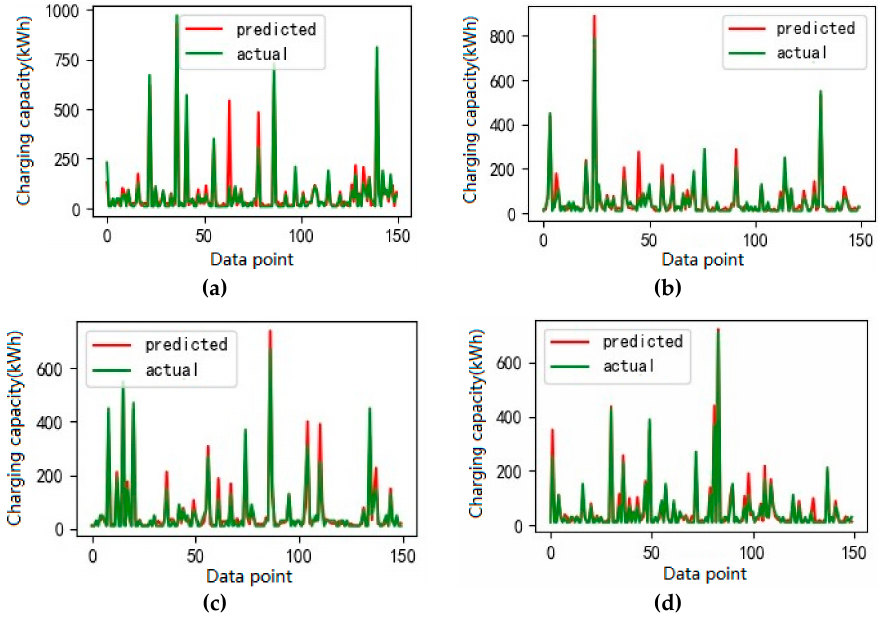
Figure 7. Performance of RF model on testing data set: ( a ) n = 40, m = 40; ( b ) n = 80, m = 80; ( c ) n = 120, m = 120; and ( d ) n = 140, m = 140.